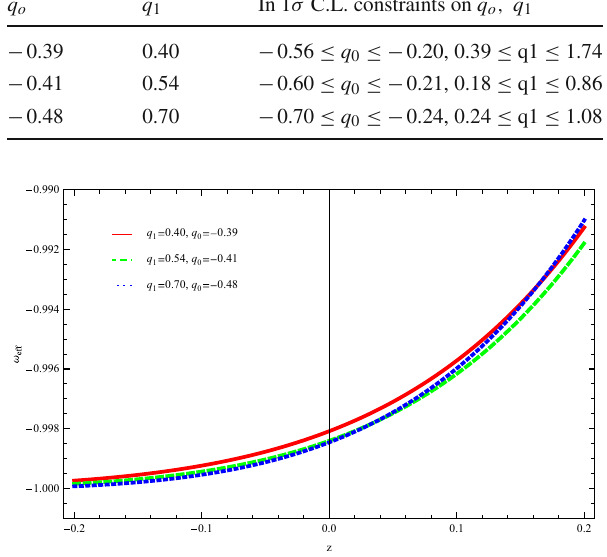
Table 1 For q o , q 1 the best fit values from CC+ H o dataset q o q 1 In 1 σ C.L. constraints on q o , q 1